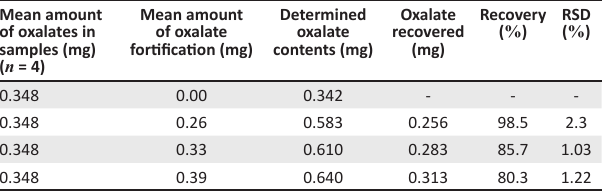
0mAU TABLE 2: Oxalate contents ( n = 5) and Mann–Whitney U test analysis. TABLE 3: Recovery of oxalates in fortified Nerium oleander samples. Mean amount Mean amount of oxalates in of oxalate samples (mg) fortification (mg) ( n = 4) mg, milligrams; RSD, relative standard deviation.